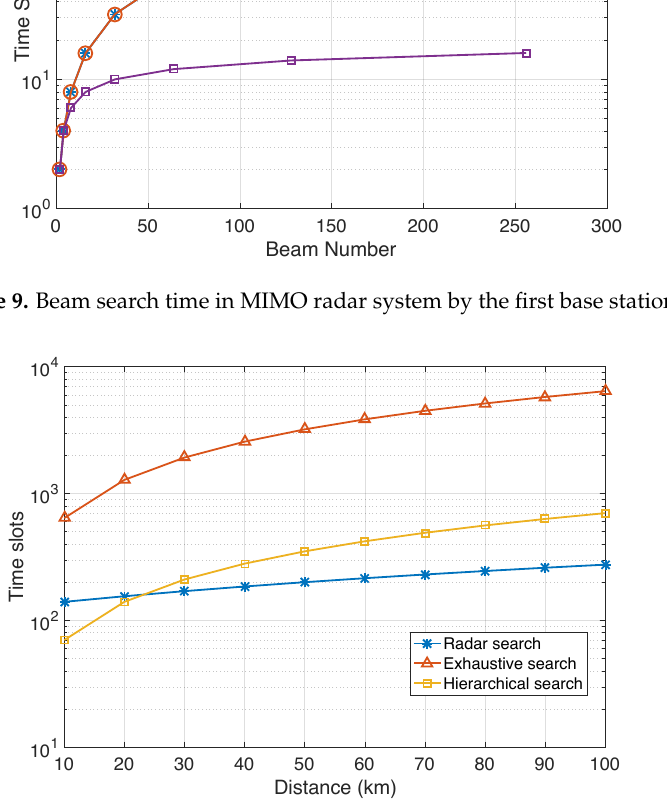
Figure 10. Beam search time in MIMO radar system from the second base